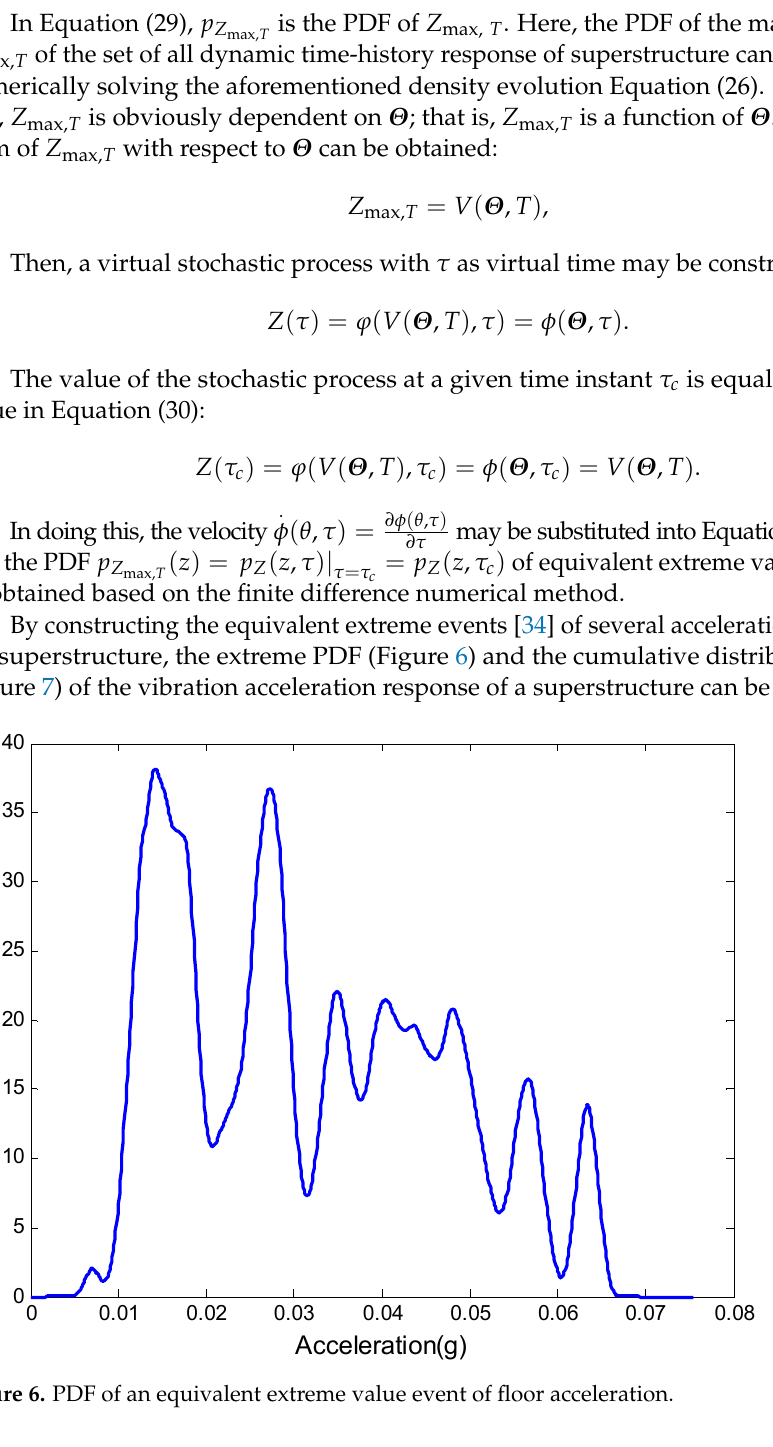
Figure 7. Vibration comfort reliability of the superstructure represented by acceleration. The comfort levels of the tunnel superstructure under the impact of subway-vibra- tion excitation can be characterized through the vibration-acceleration response of the building. According to different national design codes [39–41], various acceleration thresholds can be selected to evaluate the comfort reliability of building vibrations. The specific reliabilities are presented in Table 2. Under the control of the industrial vibration comfort standard, the reliability of the vibration comfort levels of the building satisfies the specifications (Table 2); that is, the vibration comfort dynamic reliability is 𝑅 (cid:2919)(cid:2924)(cid:2914) = 1 .